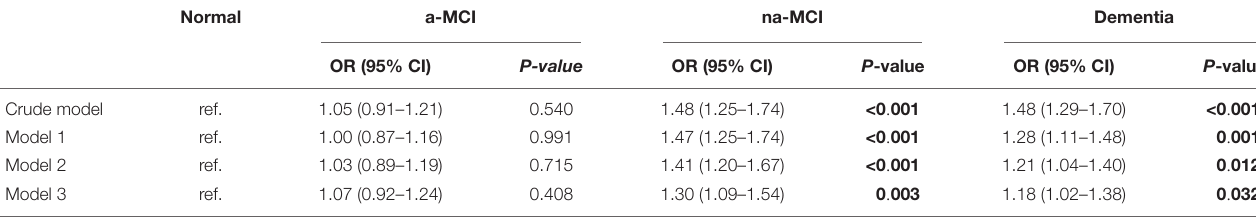
TABLE 2 | OR and 95% CI for the presence of constipation in subjects of different cognitive function groups by multivariate logistic regression model.